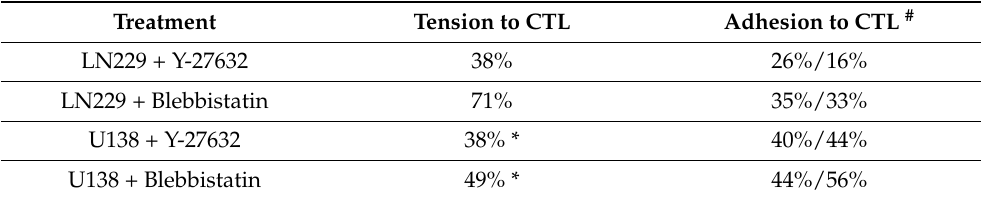
Table 1. Ratio of median adhesion and tension to control conditions. Treatment Tension to